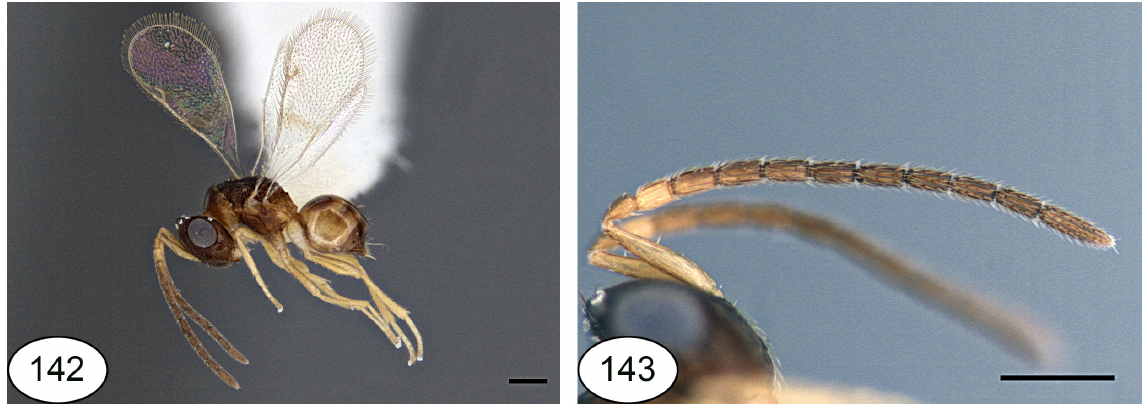
view. 143 . Antenna. Scale bars: 0.2